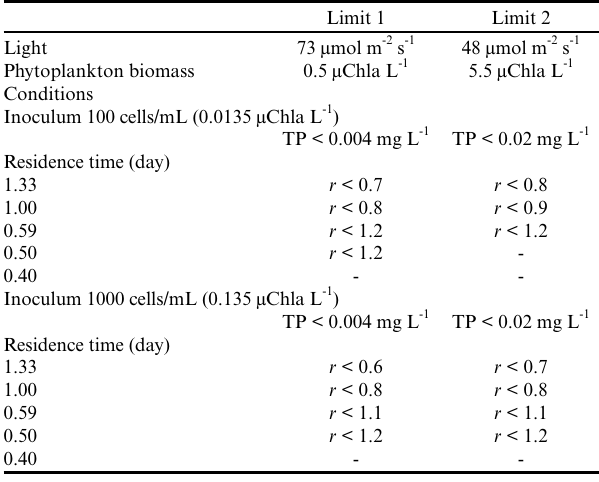
Table 4 . Model results. Phytoplankton biomass required to create conditions satisfying modeled macrophyte light